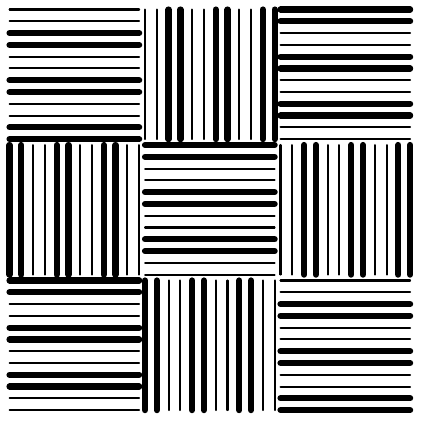
Figure 2. Plan view of the test pattern with line structures.